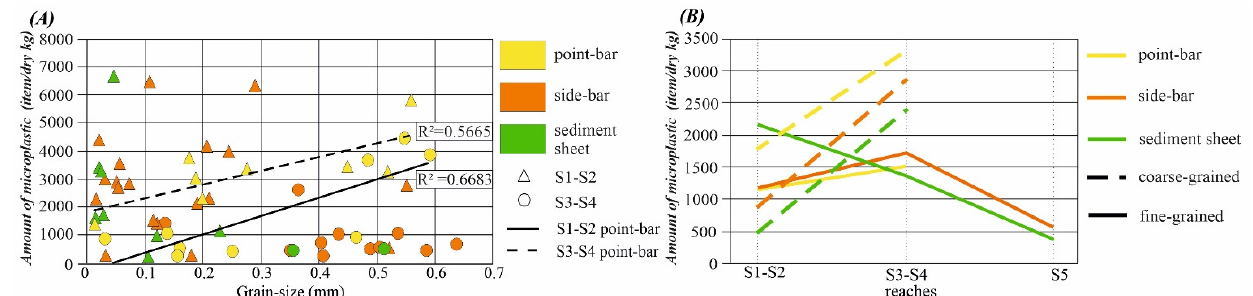
Figure 8. ( A ) Relationship between the grain size ( d 50 ) of the samples and their microplastic content (item/dry kg) collected on various in-channel forms from the reaches of the Tisza. ( B ) Spatial changes in mean microplastic content (item/dry kg) of the various forms collected from the three reaches of the Tisza. Upper Tisza: S1–S2; Middle Tisza: S3–S4; Lower Tisza: S5.